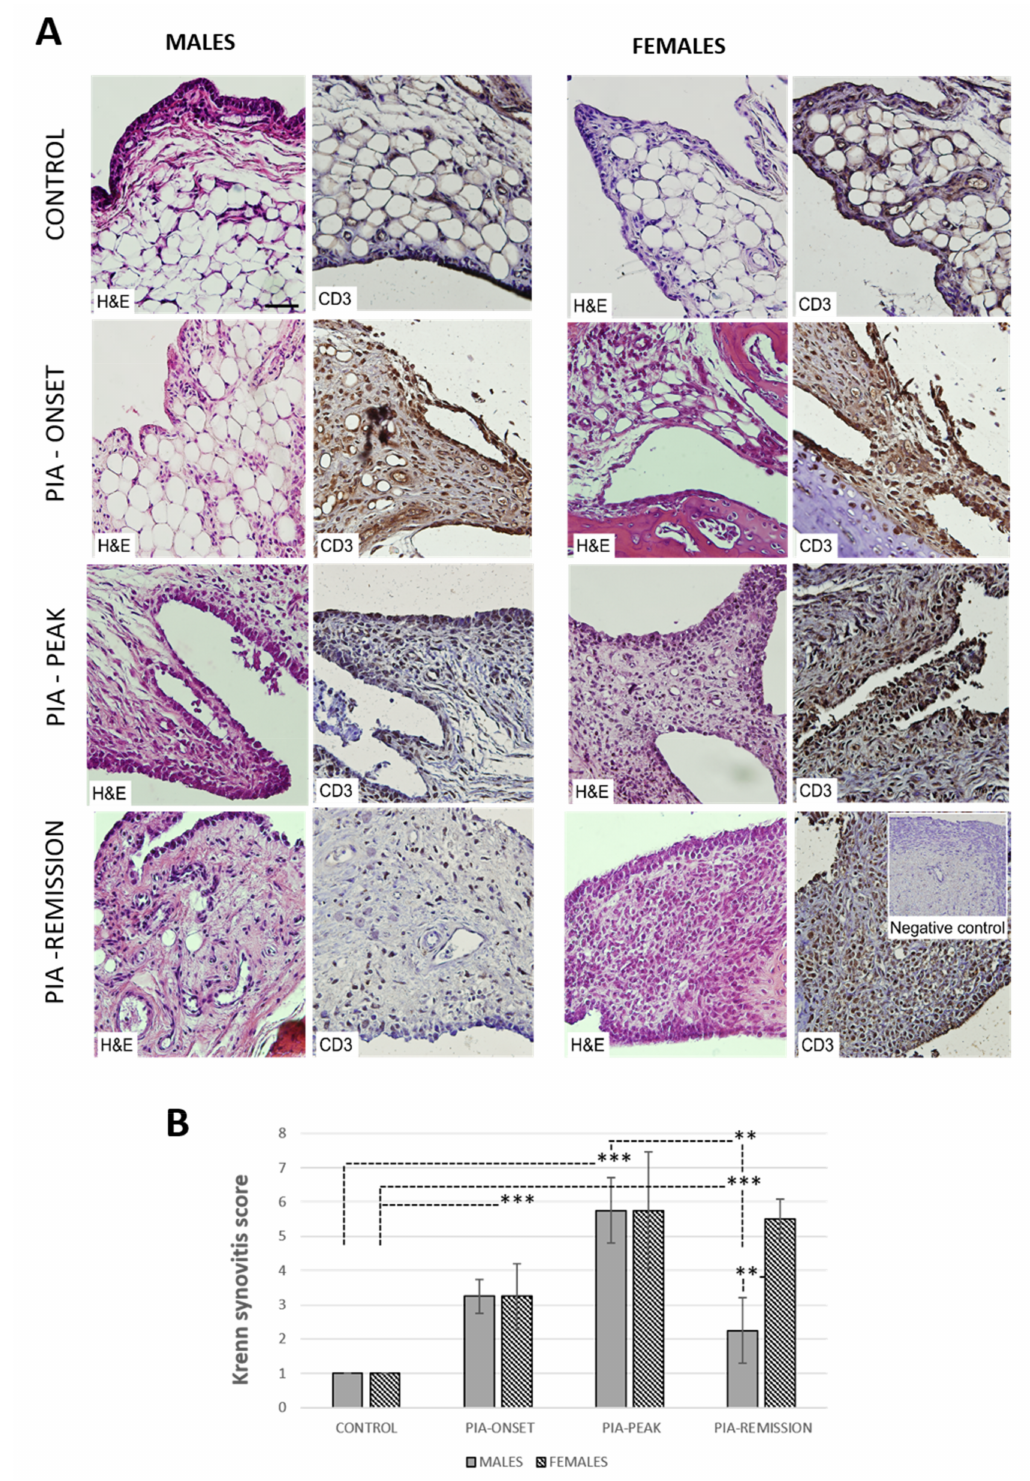
Figure 6. Pristane-induced arthritis causes greater inflammation in synovial tissue in female than in male rats. ( A ) Representative photomicrographs show staining with H&E for measuring the level of inflammation (Krenn scor- ing system) and anti-CD3 antibody for detecting T cells in paraffin-embedded sections of the metatarsophalangeal